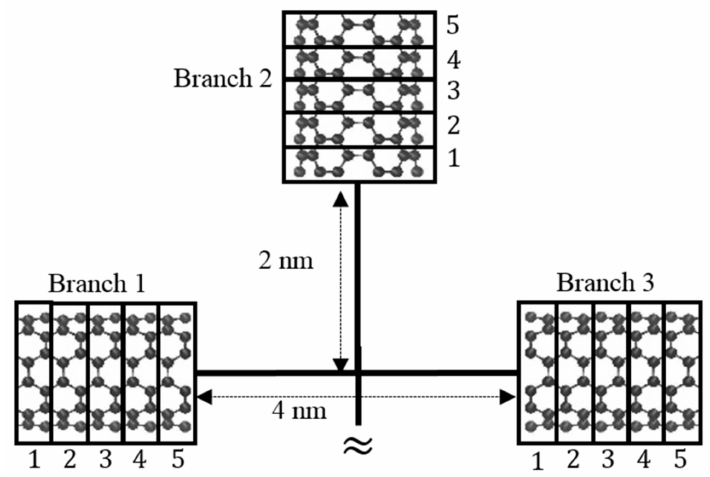
Figure 10. Illustration of atoms at different branches in cross-correlation calculation.